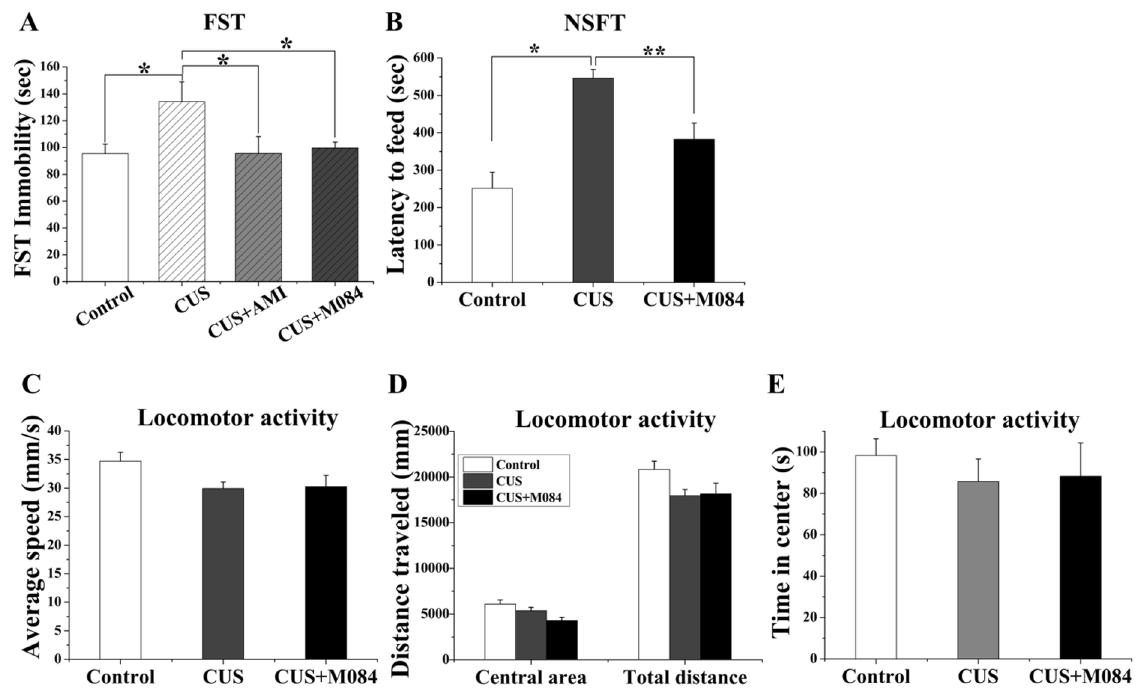
Fig 4. M084 treatment reverses the CUS-induced pathological behaviors. (A) M084 (10 mg/kg, 2 hrs) and amitriptyline (10 mg/kg, 7 days) treatment decreased immobility time in the FST of CUS-exposed mice. (B) In novelty suppressed feeding test (NSFT), CUS increased the latency to feed, while M084 treatment reversed such an effect. (C-E) In locomotor activity test, mice subjected CUS displayed moderate changes over the average speed (C), distance traveled in central area and the total distance traveled (D), and time in central area (E). M084 treatment had no effect on these changes induced by CUS. Results are showed as mean ± SEM. N = 12/group, * p < 0.05, ** p < 0.01, *** p < 0.001.